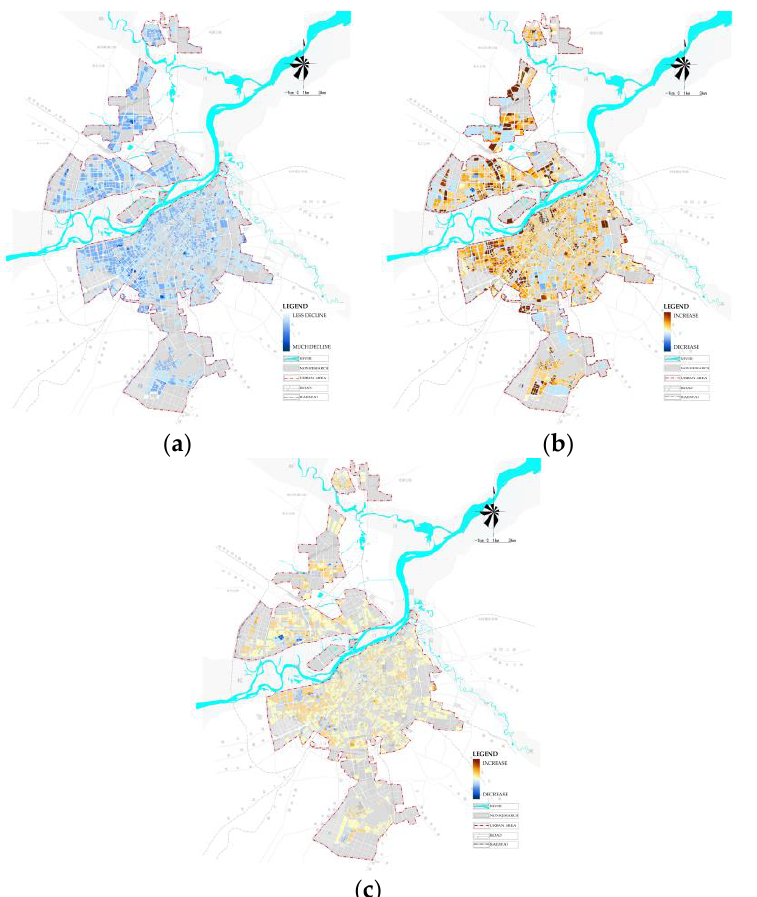
Figure 13. Change in average annual building energy consumption of the main urban area. ( a ) The average temperature increases by 1 °C; ( b ) the average wind speed increases by 1 m/s; ( c ) The relative humidity increases by 1%.